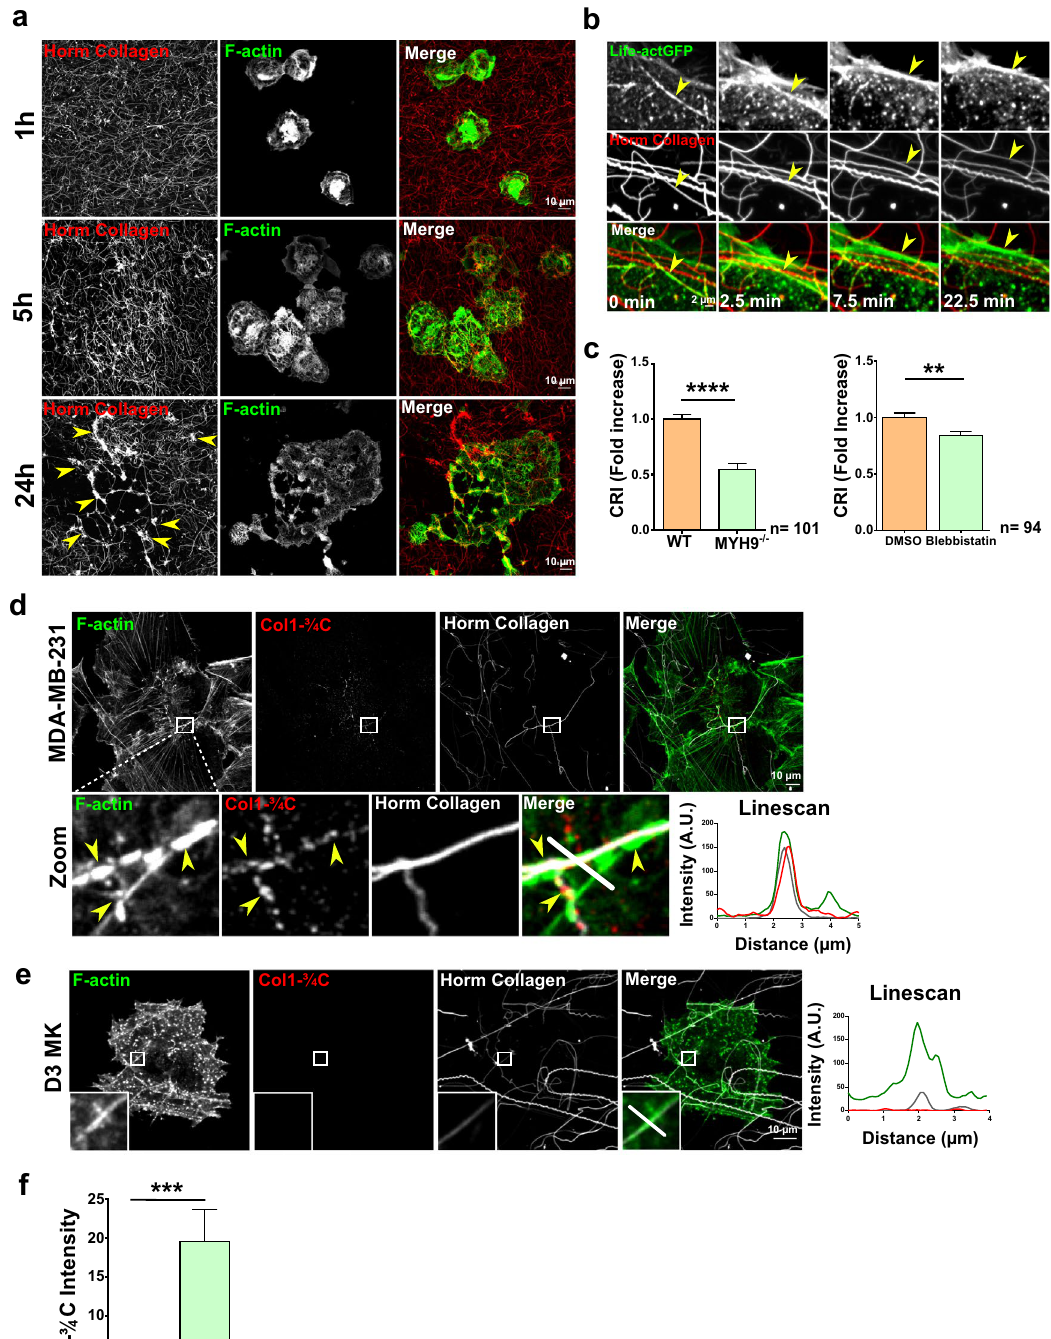
Figure 5. Mature MKs remodel fibrillar collagen matrix through traction by linear podosomes, without collagenase involvement. ( a ) D3MKs were plated on labelled 100 µg/ml Horm Collagen (red), and allowed to spread for the indicated times before fixation and F-actin staining (green). Confocal images were then taken. Scale bars = 10 µm. ( b ) Lifeact-GFP-expressing D3MKs were cultivated on 100 µg/ml labeled-Horm Collagen (red). Confocal videomicroscopy was performed and images taken every 30 s. Yellow arrows show a linear podosome on a collagen fiber. ( c ) Collagen remodeling index (fold increase) was calculated from WT treated or not with DMSO (vehicle) or blebbistatin (20 µM) and MYH9 −/− D3MKs cultured on 100 µg/ml of labeled-Horm collagen. ( d ) MDA-MB-231 cells or ( e ) D3MKs were cultured for 6 h on 100 µg/ml of labeled-Horm collagen (white) prior staining for F-actin (green), or collagenase-cleaved collagen type 1 neoepitope (Col1-3/4C, red). Yellow arrows point to a site of collagen cleavage associated to a linear invadosome along fibers bundles. Linescans show the distribution of fluorescence along the white line. Scale bars = 10 µm. ( f ) Graph corresponds to the fluorescence intensity of Col1- 3/4 C in MDA-MB-231 and D3MKs. Values (mean ± S.E.M.) are from 3 to 5 independent